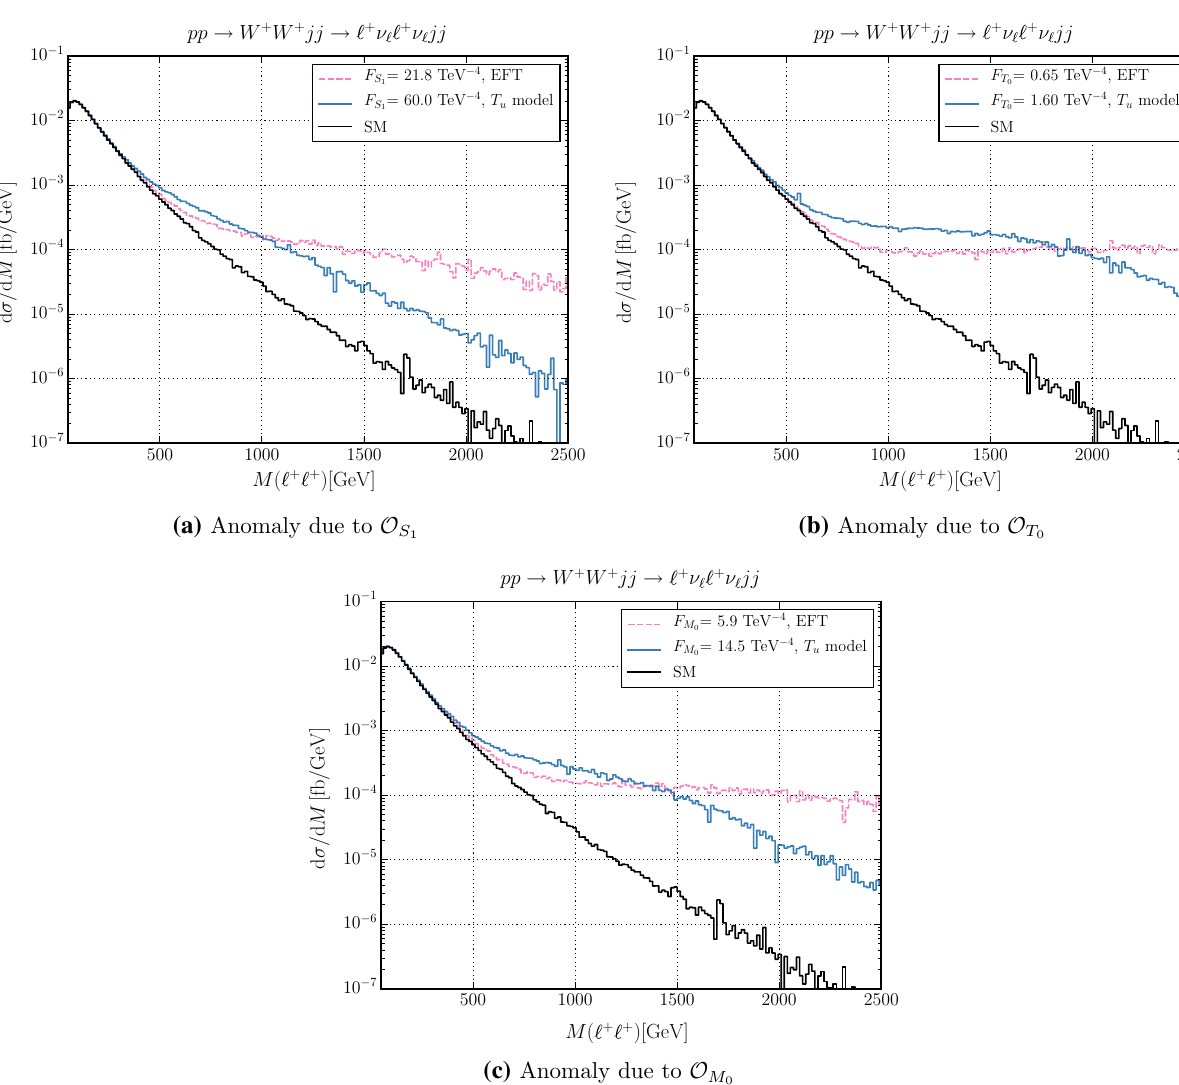
Fig. 5 Differential cross section as a function of the invariant mass m (cid:6)(cid:6) of the charged leptons for pp → (cid:6) + ν (cid:6) (cid:6) + ν (cid:6) jjX . The solid black line shows the SM, while the dashed pink solid line shows the cross section for the anomalous coupling using the present CMS upper limit.